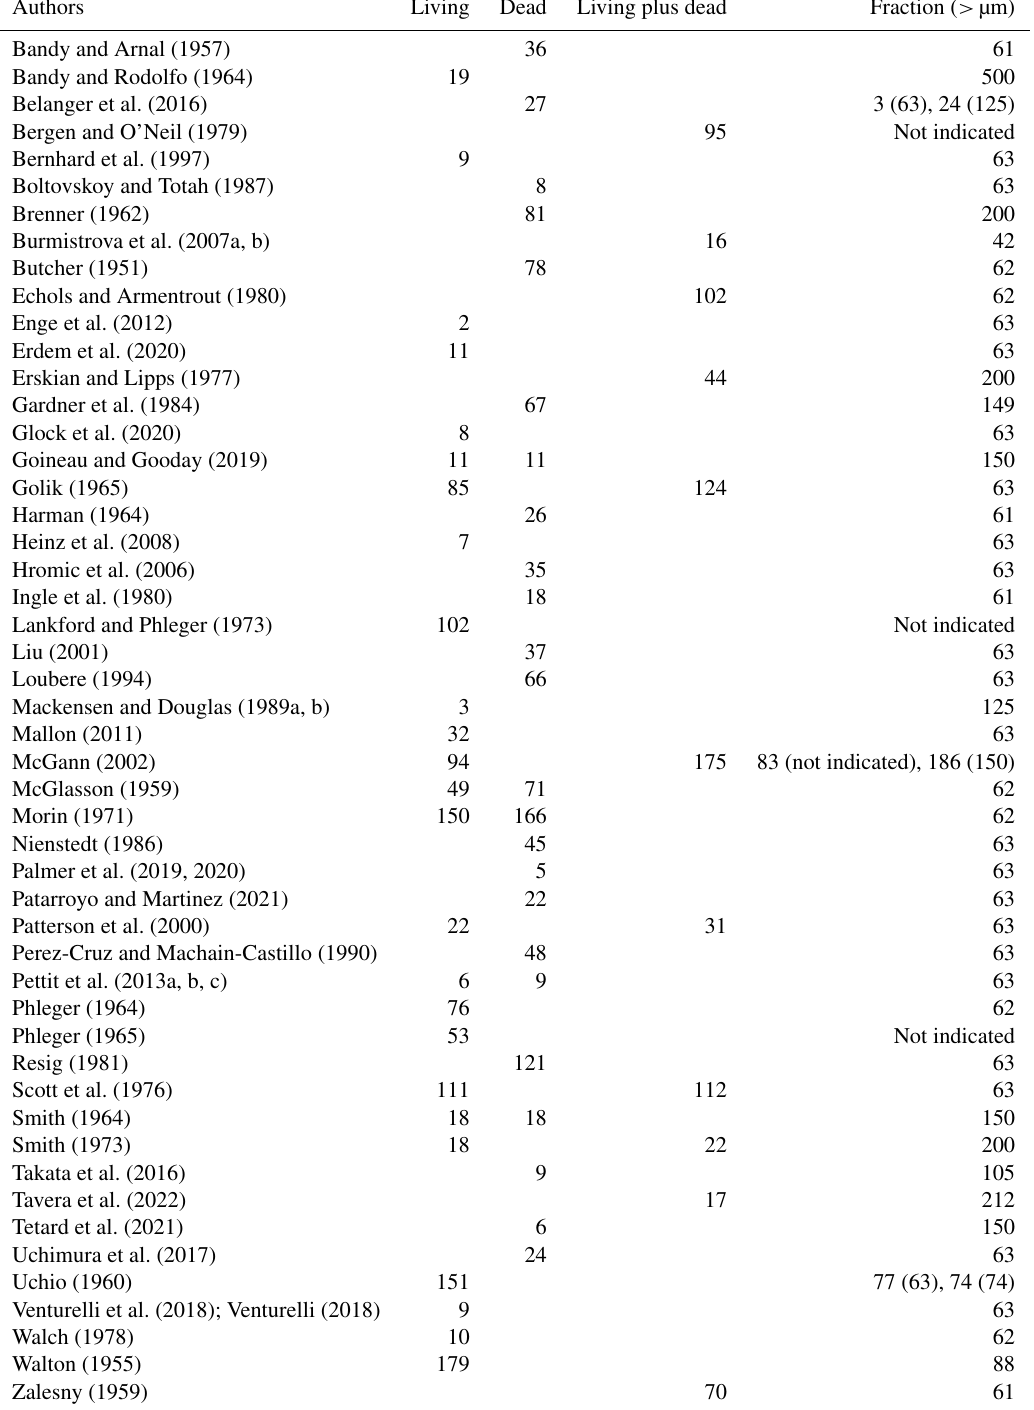
Table A1. Number of samples per contributor, type of assemblage, and size